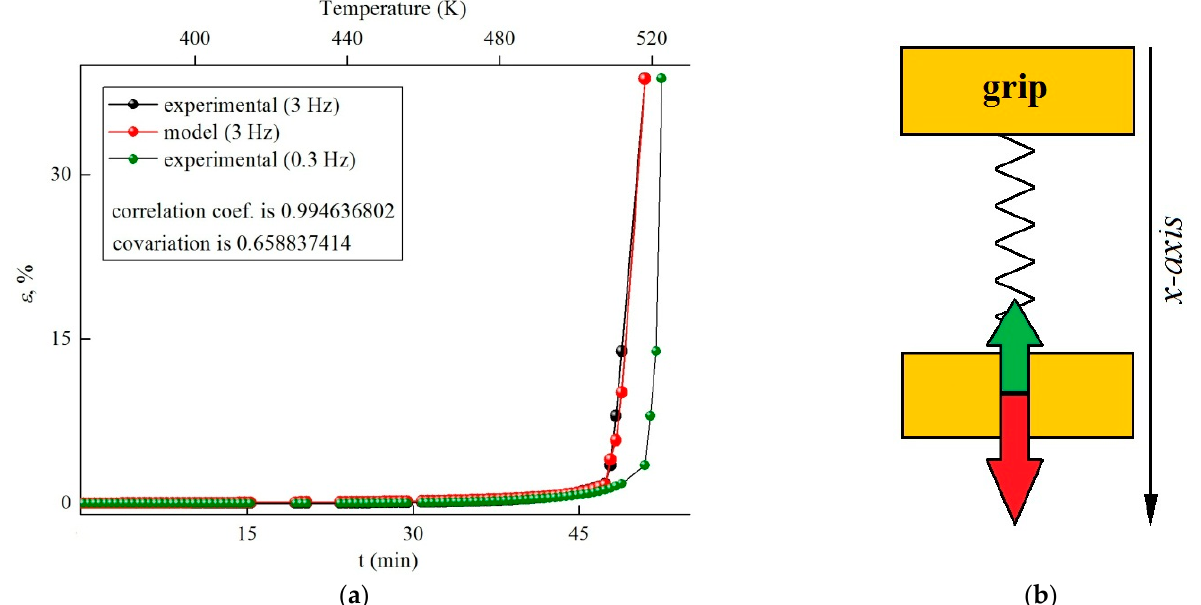
Figure 2. X-ray diffraction curve. Deformation of the Al 85 Y 8 Ni 5 Co 2 metallic glass specimen at the 0.3 and 3 Hz load frequencies is plotted in Figure 3a.